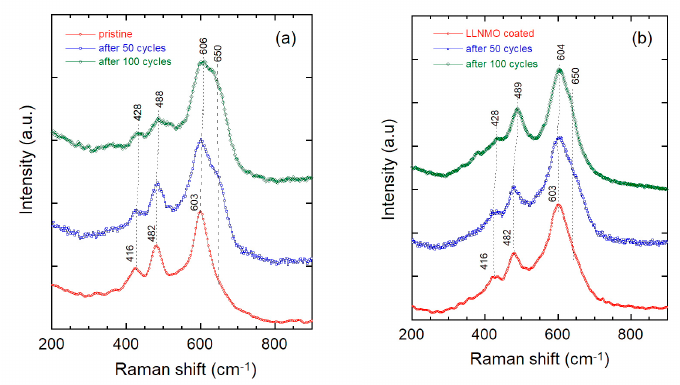
Figure 14. Ex situ Raman spectra of ( a ) pristine and ( b ) AlF 3 -coated LLNMO electrodes after 50 and − 1 current 100 cycles at 30 mA g − 1 current density. 100 cycles at 30 mA g